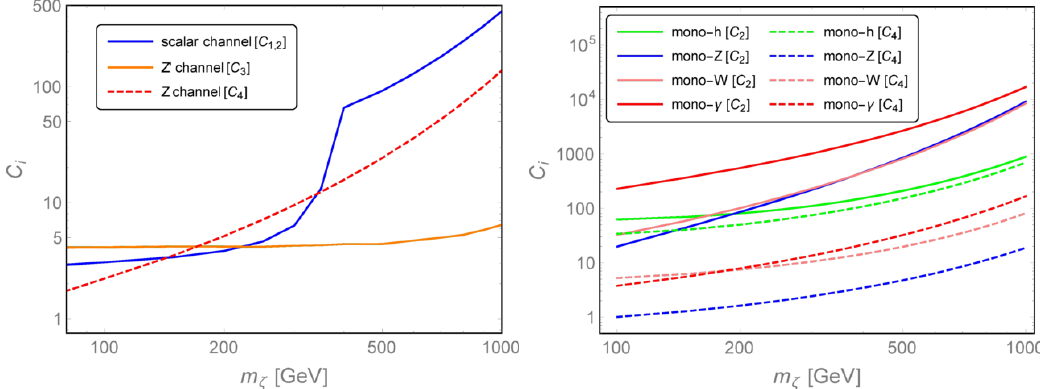
Figure 5 . Left panel : constraints on the e(cid:11)ective couplings C i of DM in the monojet channel from 13 TeV ATLAS data [46]. Right panel : constraints on the e(cid:11)ective DM couplings C i in the mono-Higgs, mono- W=Z and mono-photon channels. For simplicity in both the panels we have set C 1 = C 2 and the scalar mixing cos (cid:18) = 0 : 865. See text for more